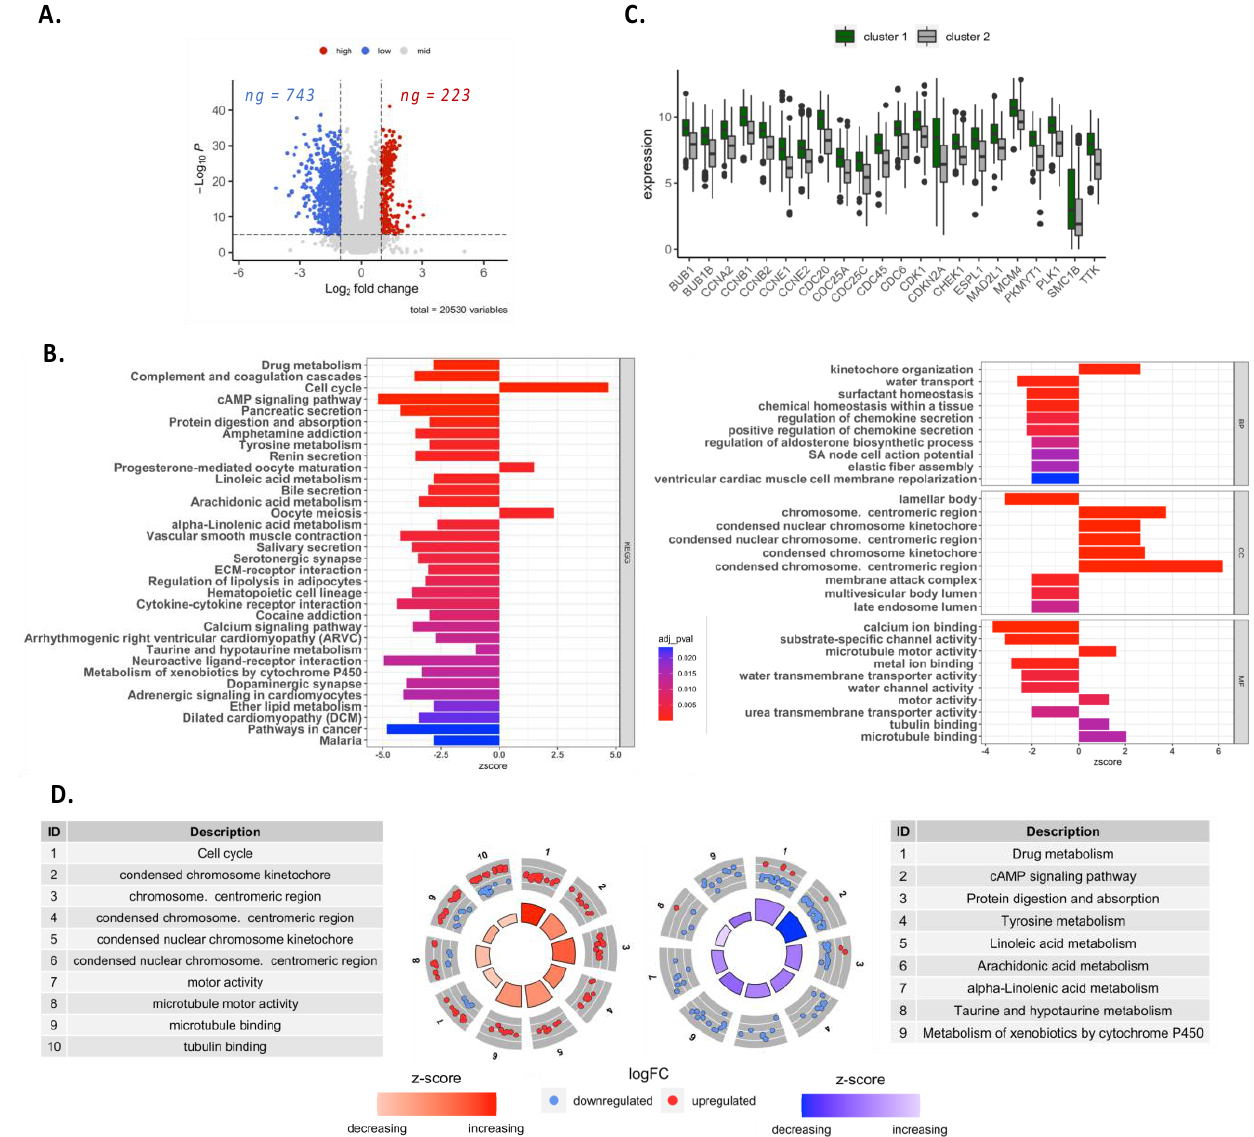
Figure 3. Differential gene expression and enrichment analysis for clusters. ( A ) Volcano plot for differential expression analysis in all genomes (cluster 1 versus cluster 2) in the TCGA-LUAD datasets. ( B ) Differential gene GO and KEGG enrichment analysis, BP stands for biological processes, CC stands for cellular components, and MF stands for molecular function. ( C ) Significant expression of genes involved in cell cycle pathways. ( D ) Representation for gene expression in GO and KEGG enrichment analysis for anabolism (left) and catabolism (right) pathways.